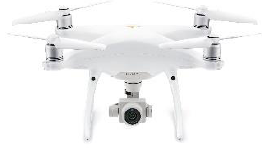
Figure 1. DJI Phantom 4 pro